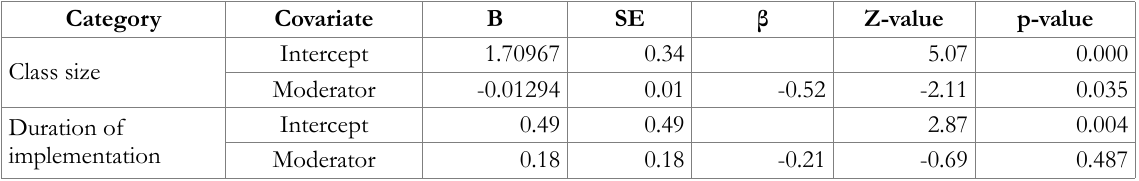
Table 10. Results of moderator analysis according to class size and duration of